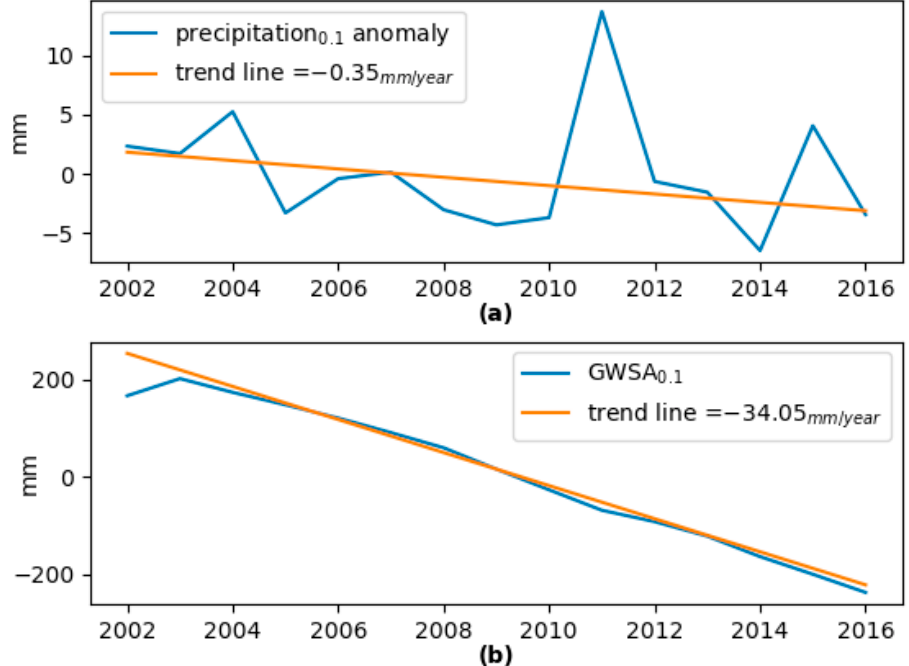
Figure 8. Qazvin Plain area average 𝑃𝑟𝑒 (cid:2868).(cid:2869) ( a ) and 𝐺𝑊𝑆𝐴 (cid:2868).(cid:2869) ( b ) trend on yearly scale.